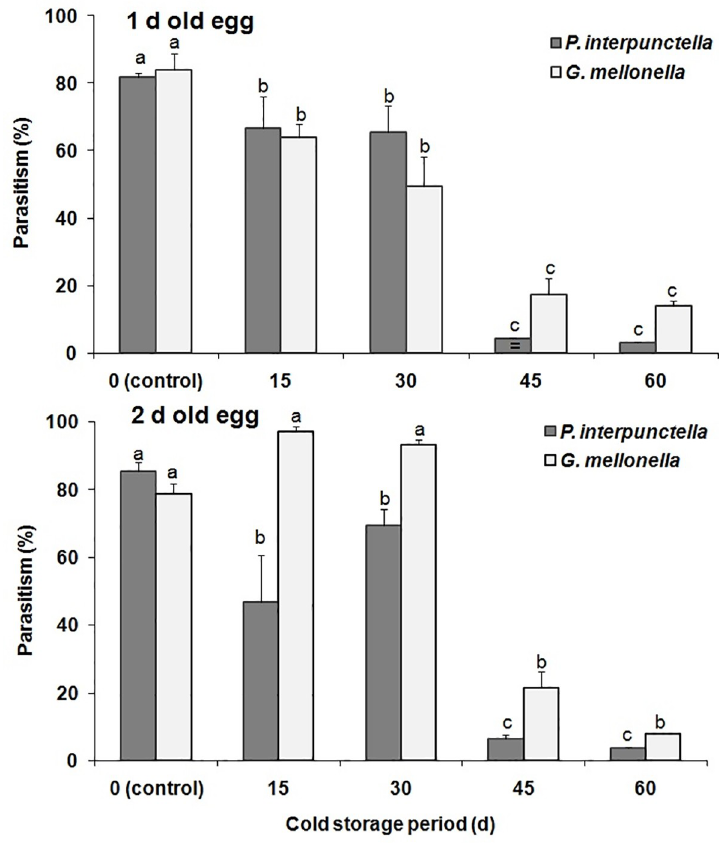
Fig 2. Mean percentage (% ± SE) of parasitism by T . evanescens in P . interpunctella and G . mellonella eggs of different ages on exposed to 9˚C for different intervals (within each egg age and species, bars followed by the same letters are not significantly different; HSD test at